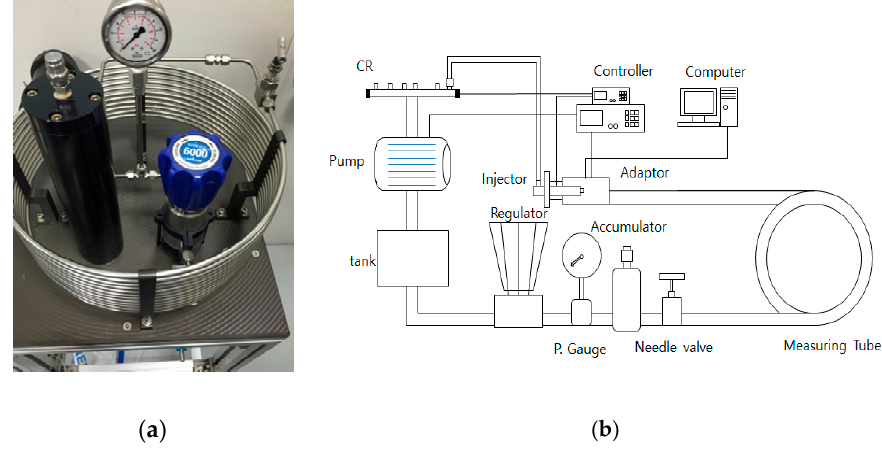
Figure 4. Injection rate measurement; ( a ) Injection rate measuring device, ( b ) Schematic diagram. Table 2. Experimental conditions for measuring injection rate.